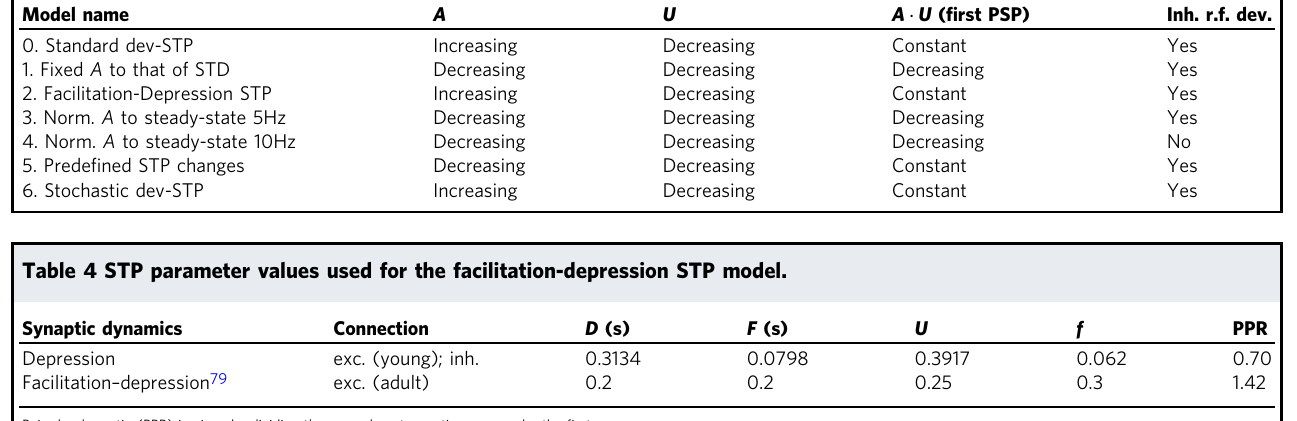
Table 3 Summary table of the various variants of dev-STP models and how these impact the different parameters. Model name